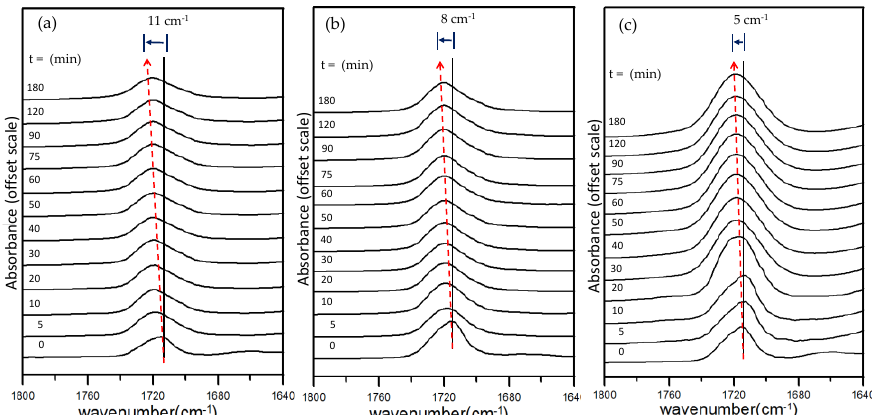
Figure 5. FTIR spectra in the carbonyl-stretching region of phenoxy/PBT blends after heating at 260 °C for various periods of time as indicated: phenoxy/PBT = ( a ) 9/1, ( b ) 5/5, and ( c ) 1/9.